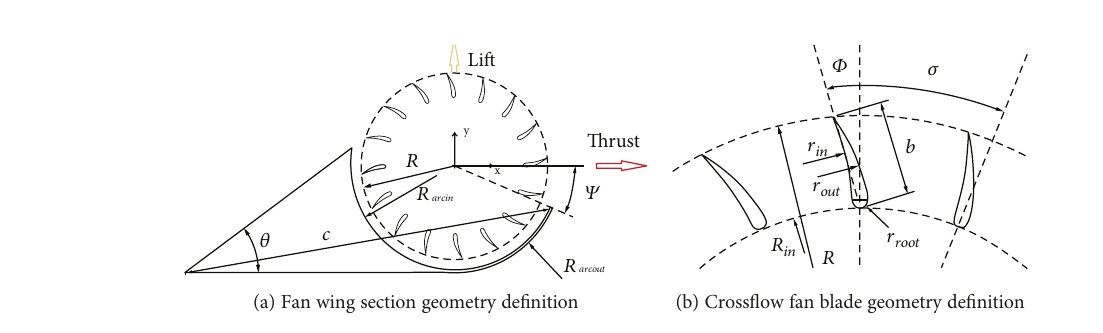
Figure 2: Fan wing section.